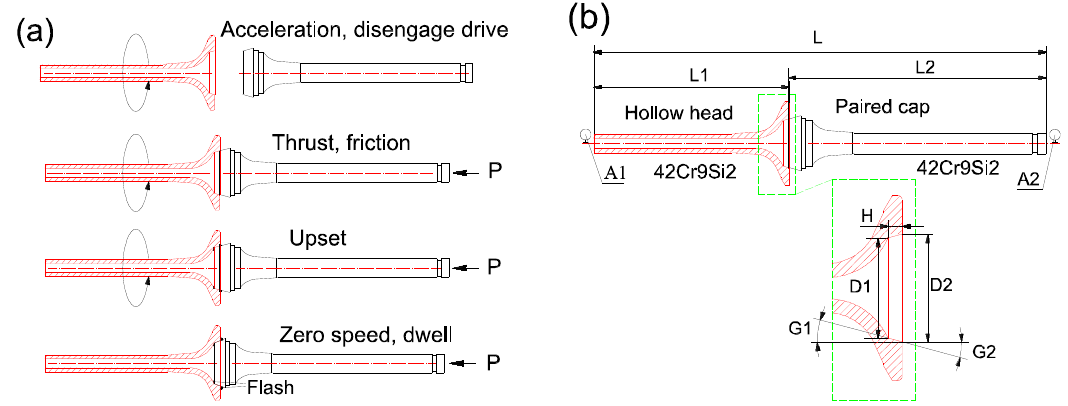
Figure 5. ( a ) Basic steps in two-stage inertia friction welding; ( b ) the geometry of hollow head engine valve workpiece for friction welding.